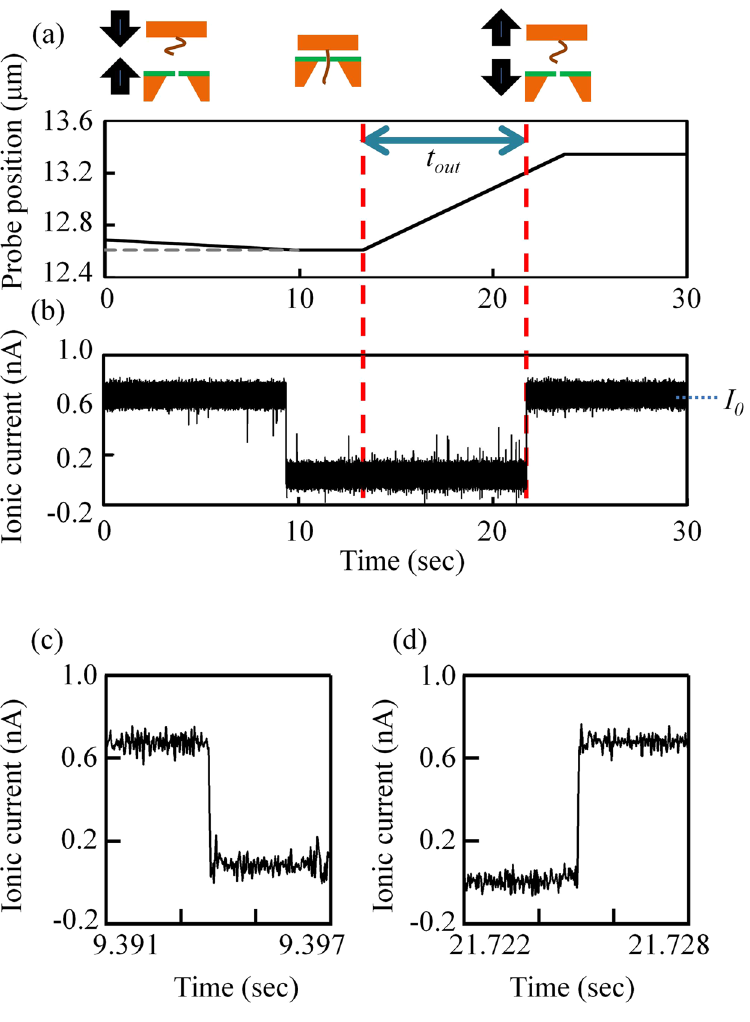
Figure 3. Insertion and removal of the DNA from the nanopore. ( a ) Time trace of the probe position and the ( b ) corresponding ionic current through the nanopore. ( c ) Magnified views around the time points when the ionic current was blocked. ( d ) Magnified views around the time points when the ionic current was recovered.